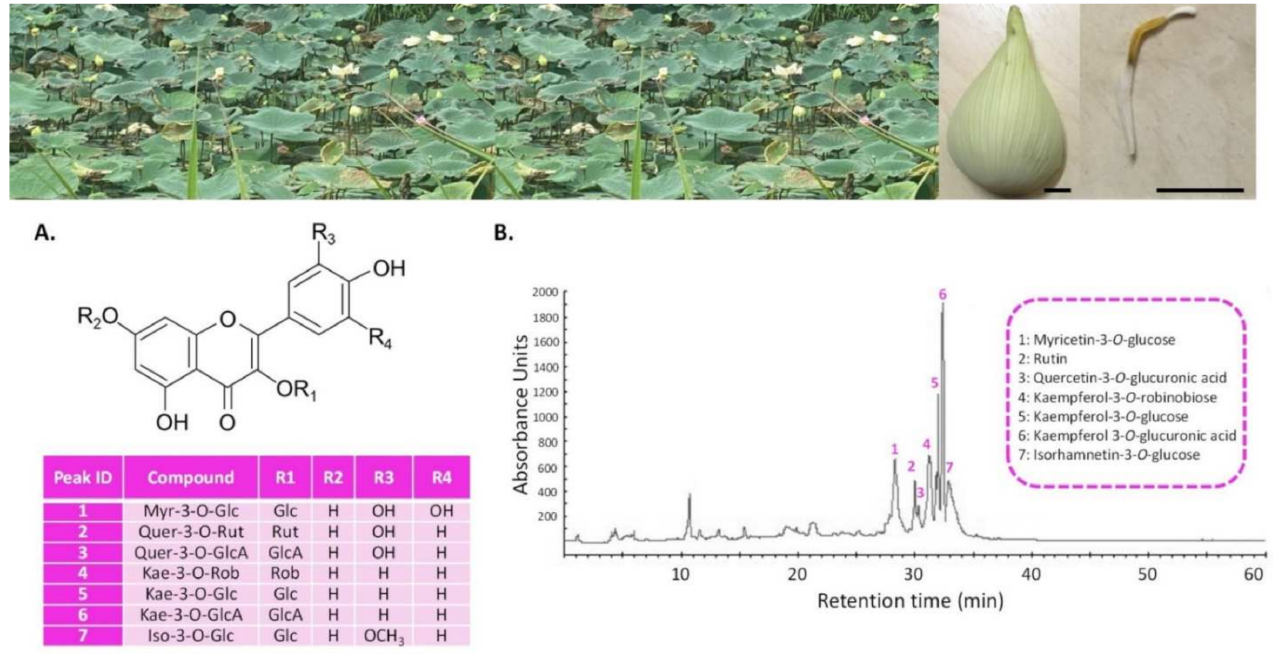
Figure 1. ( A ) Pictures of sacred lotus’s habitat, perianth, and stamen; bar = 1 cm; ( B ) Structures and corresponding numbers on the HPLC chromatogram of the main phenolic compounds considered in this study: 1 . Myr-3- O -Glc: myricetin-3- O -glucose; 2 . Quer-3- O -Rut: quercetin-3- O -rutinoside